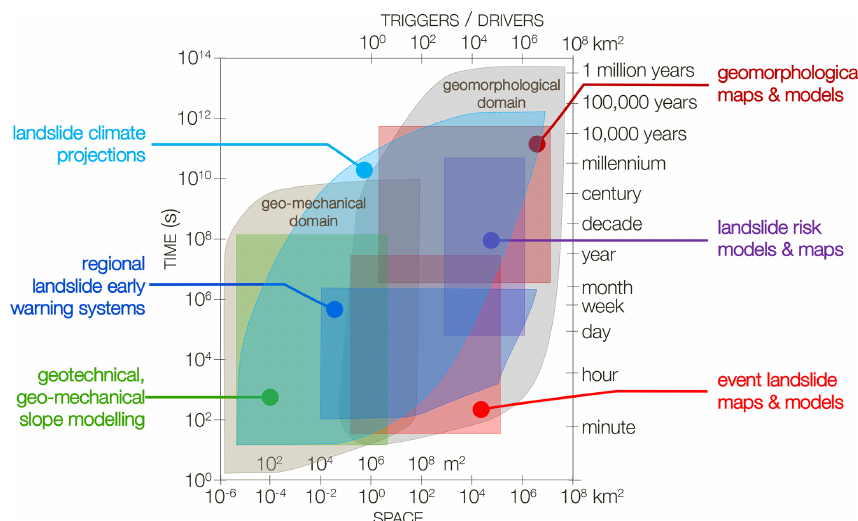
Figure 1. Space (lower x axis)–time ( y axes) chart showing main geomorphological and geo-mechanical landslide domains, and typical length scale of main meteorological and geophysical triggers and drivers of populations of landslides. Coloured polygons show approximate sub-domains for typical landslide hazards and risk mapping and modelling efforts. Modified after Guzzetti